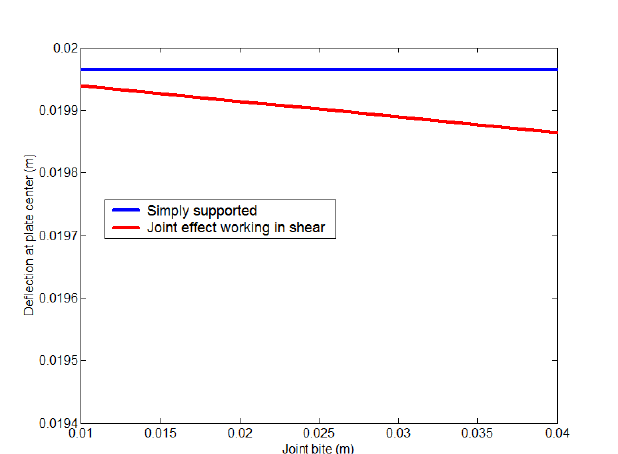
Fig.8:Calculation of the contribution of the joint working in shear on the maximum value of the glass plate deflection at its center change